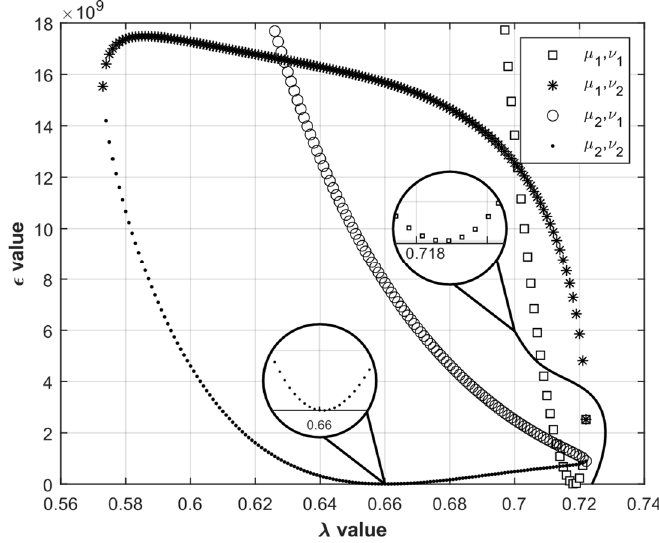
Figure 5. The graphics of ϵ versus λ .